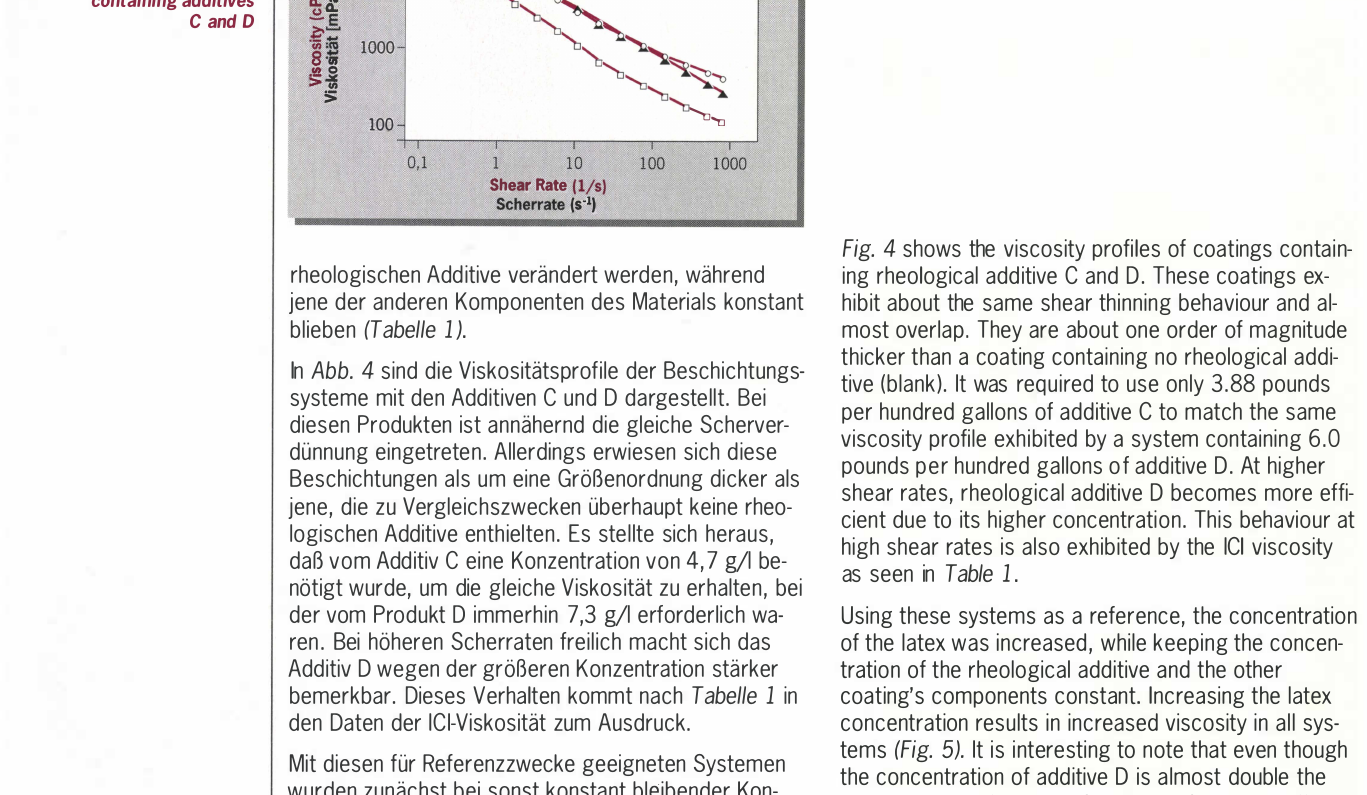
Fig. 4: Shear thinning profiles of latex paint containing additives C and D